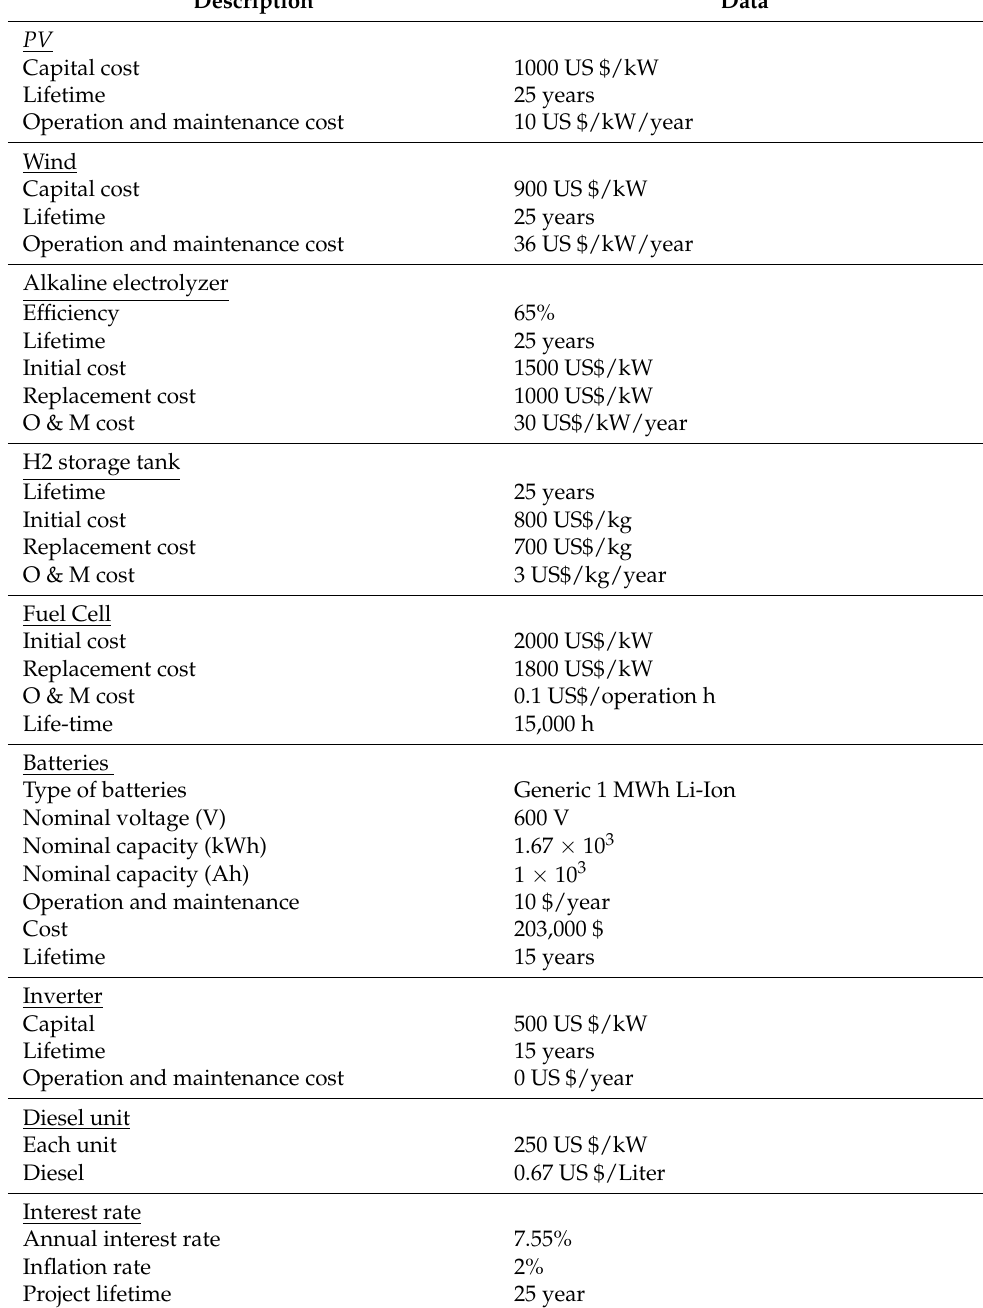
Table 2. Technical data and study assumptions of PV, diesel unit, inverter, and batteries